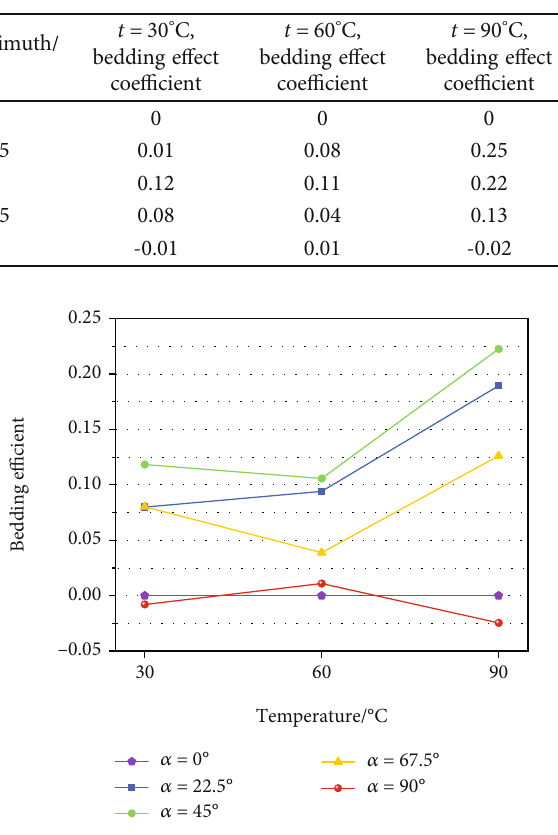
Figure 6: Shale peak intensity variation